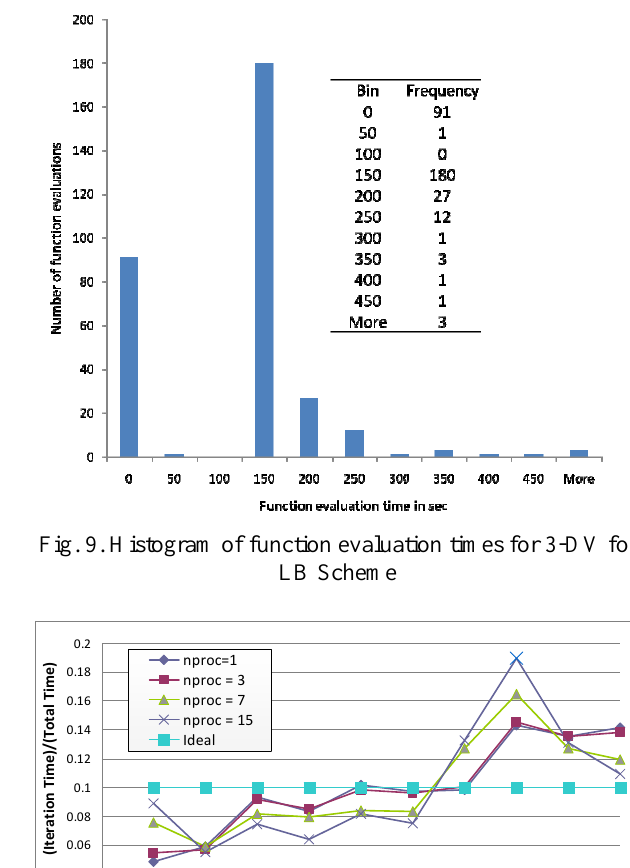
Fig. 10. Plot showing the variation of computation time of every iteration for different number of processors (SATR